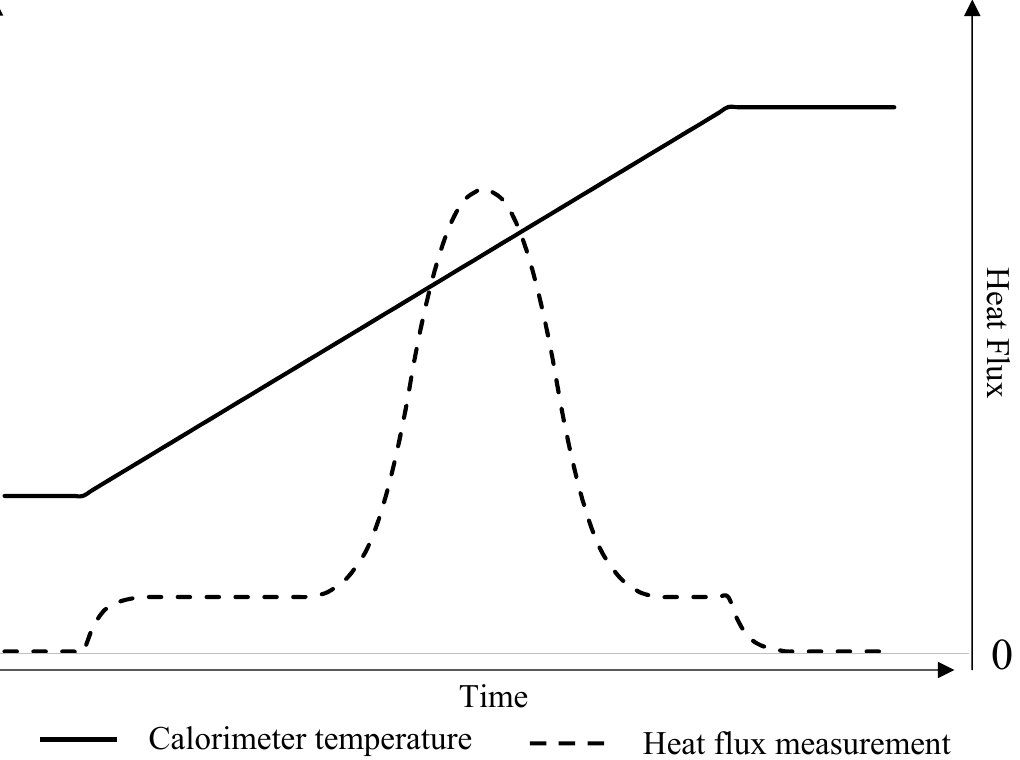
Figure 1. Principle of the DSC method.